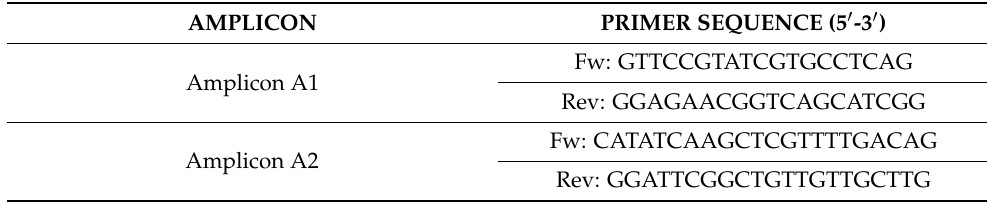
Table 1. Primers used for generating different MTM1 cDNA